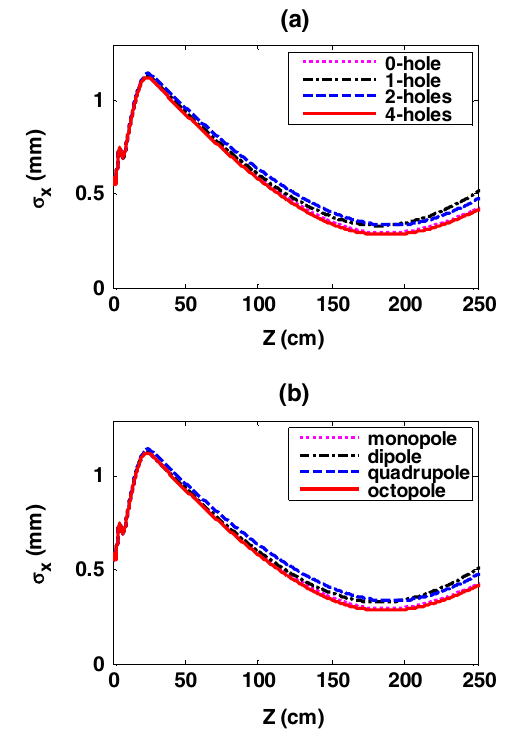
FIG. 8. X rms beam size of the rf gun with solenoid field for the beam charge 0.1 nC (a) with the four rf gun models and (b) with four artificial field